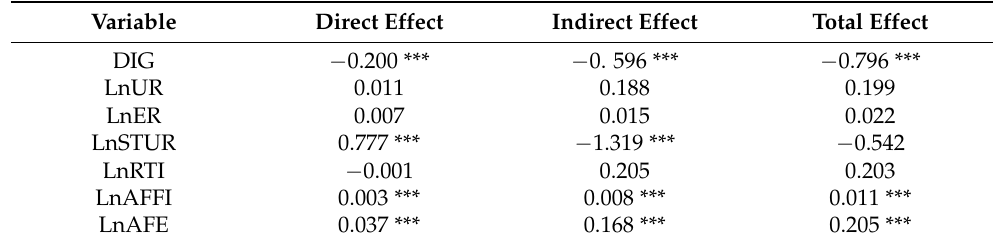
Table 9. Direct effect, indirect effect, and total effect of factors affecting agricultural carbon